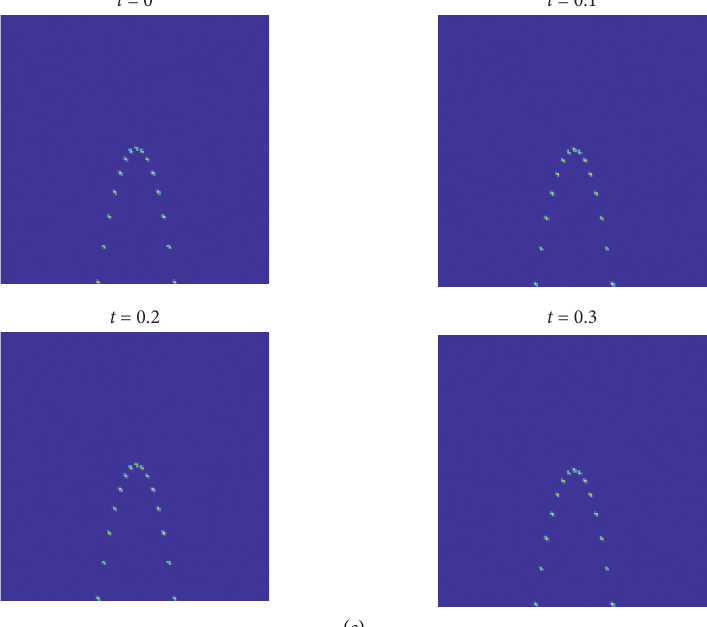
Figure 3: Numerical solution and pattern of Experiment 1 with initial condition η ( x,y, 0 ) � ones ( N ) + sec h (( x 2 /0 . 02 ) − 9 + 2 · ( y /0 . 01 ))